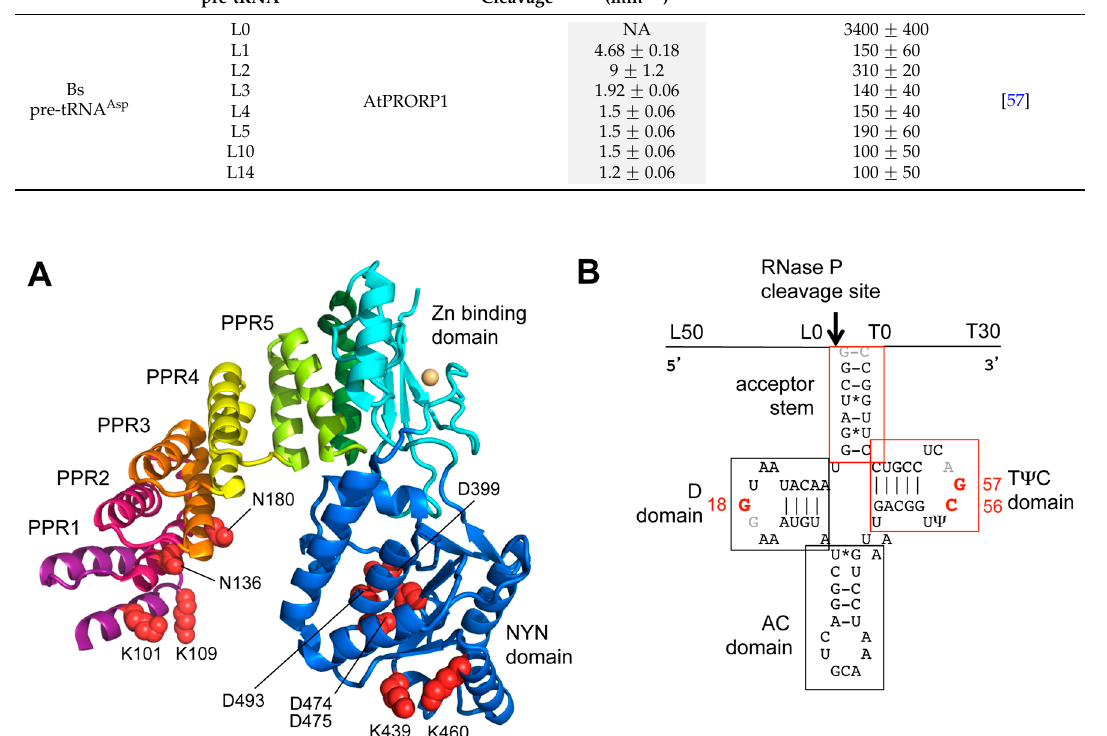
Figure 2. PRORP and pre ‐ tRNA cis ‐ elements required for RNase P activity. ( A ) Arabidopsis PRORP1 crystal structure shows the three domain organization of PRORP, with the PPR and NYN domains connected by a zinc ‐ binding domain. Side chains of residues that were shown to interact with pre ‐ tRNA and/or to be essential for RNase P activity by mutagenesis analyses (see Table 1) are shown in space ‐ filling mode (red spheres); and ( B ) a secondary structure model of Arabidopsis mitochondrial pre ‐ tRNA Cys . L and T indicate the leader and trailer sequences and their respective length spans in the different substrates used in the analyses summarized in Table 2. tRNA domains and residues that were found to be essential for RNase P activity are indicated in red. Other positions where mutations had no effect on activity are shown in grey.